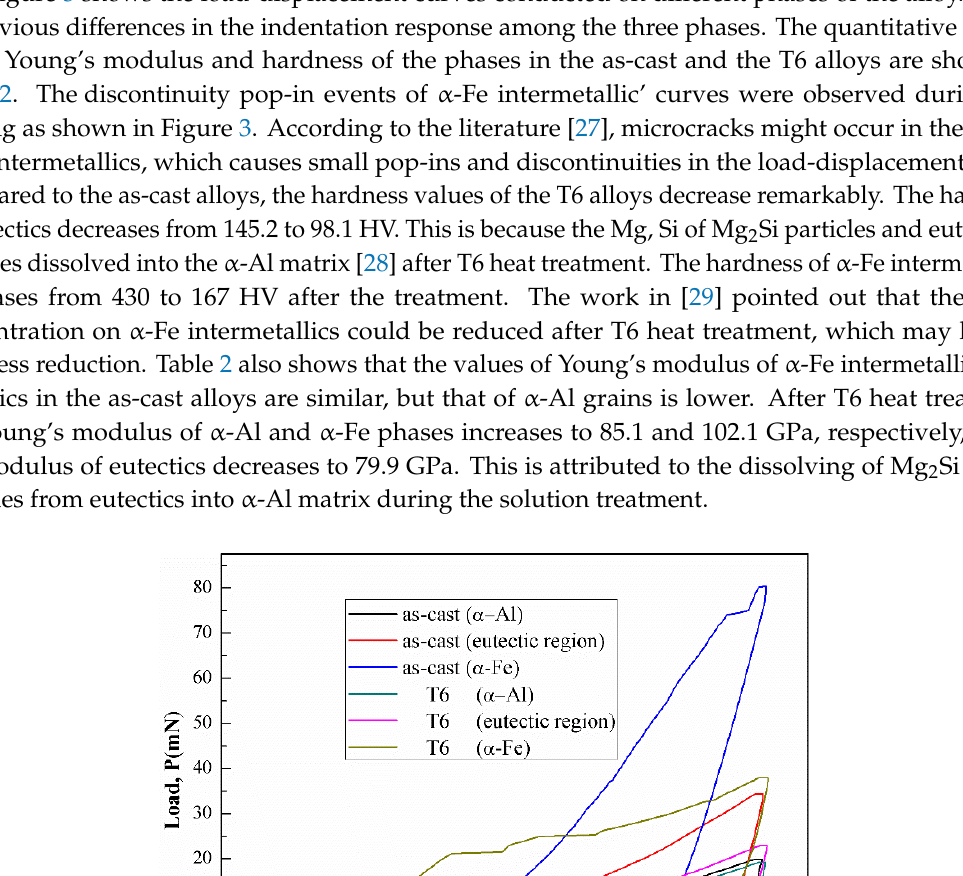
Figure 2. The microstructure of AlSiMgMn alloy. ( a , b ) As-cast; ( c , d ) T6 heat treatment; ( e ) energy dispersive spectroscopy (EDS) analysis results of α -Fe intermetallics.